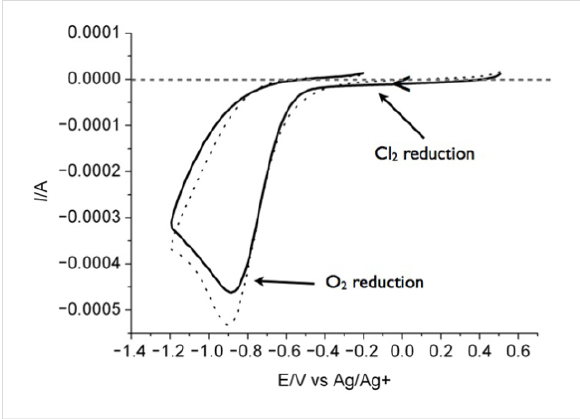
Figure 11: Cyclic voltammograms of DMF/4.5 wt % LiBr solution heated at 80 °C for 30 min (plain line) and 14 hours (dotted line). Glassy carbon electrode, Ag/AgCl, Pt, sweep rate 50 mV·s − 1